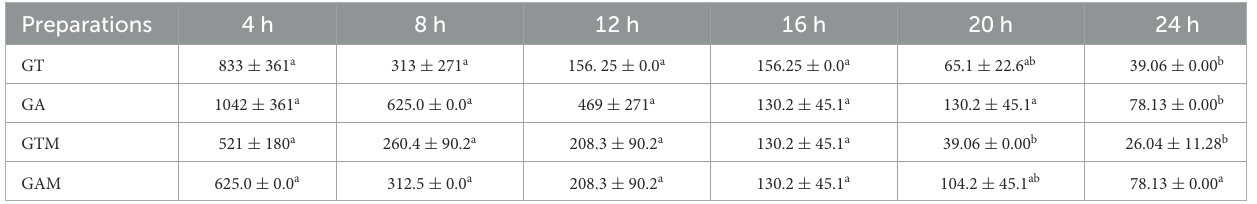
TABLE 5 Comparison of the minimum inhibitory concentrations ( µ g/mL) of different gel-based preparations against S. agalactiae at each time interval. Preparations 4